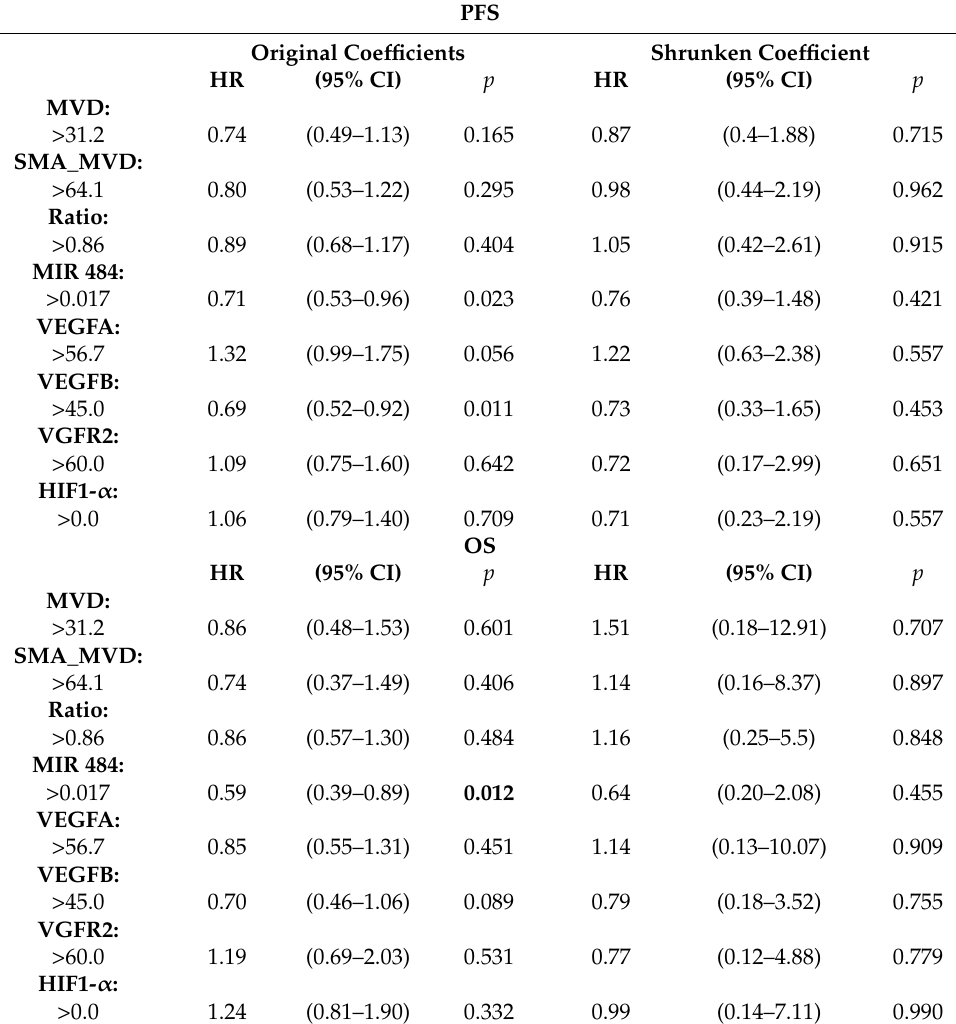
Table 2. Multivariable analysis of biomarkers best cutoff for PFS and OS adjusted for clinical characteristics, original and shrunken